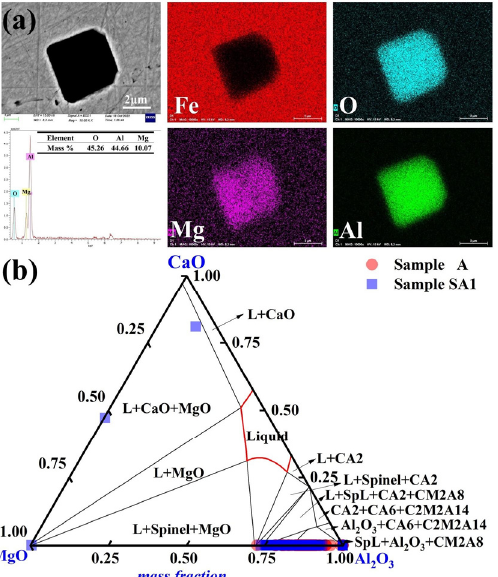
Figure 4. Common inclusions in Sample A1 had the following morphology and composition: ( a ) elemental distribution of the point inclusions and ( b ) composition distributions of the inclusions in Samples A and A1 in the MgO-Al 2 O 3 -CaO phase diagram. At 1600 °C, the solid lines depict the boundaries between several phases.